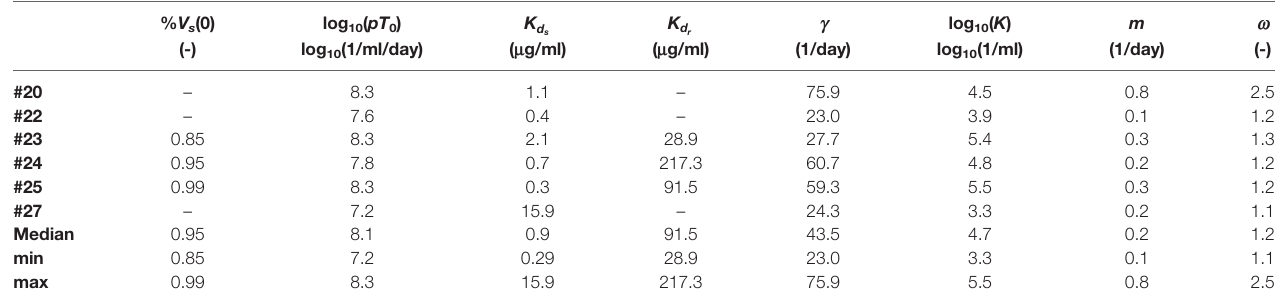
TABLE 3 | Parameter estimate of the models with the lowest BIC values in Table 2 for each individual. % V s